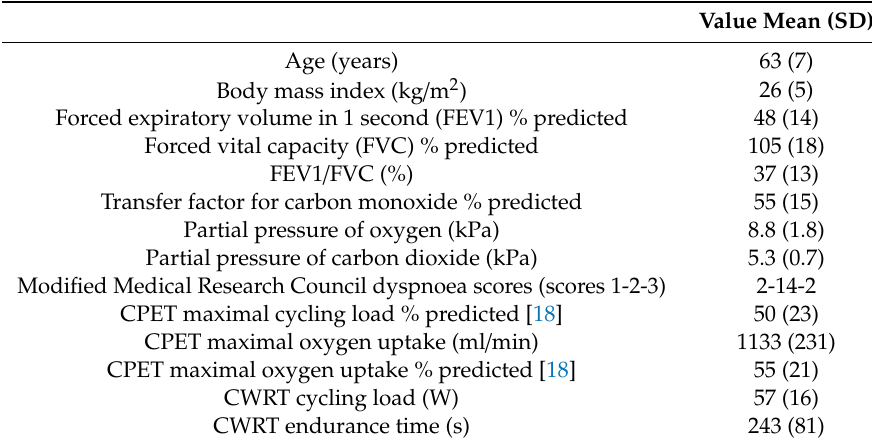
Table 1. Patient characteristics.